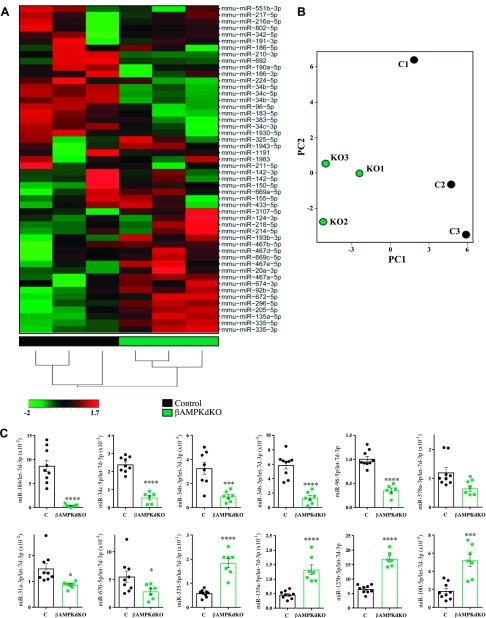
AMPK regulates miRNA expression in pancreatic islets. A, B) Heat map and unsupervised hierarchical clustering (A) and PCA (B) on the 3 control (black, C) and 3 βAMPKdKO (green, KO) samples and top 50 miRNAs with the highest sd. C) miRNA expression was assessed by RT-qPCR in isolated islets from βAMPKdKO (green) and littermate control (C, black) mice. Each dot represents islets from a single mouse. Data are expressed as relative to the endogenous control let-7d-3p. *P < 0.05, ***P < 0.001, ****P < 0.0001 (Student’s t test).